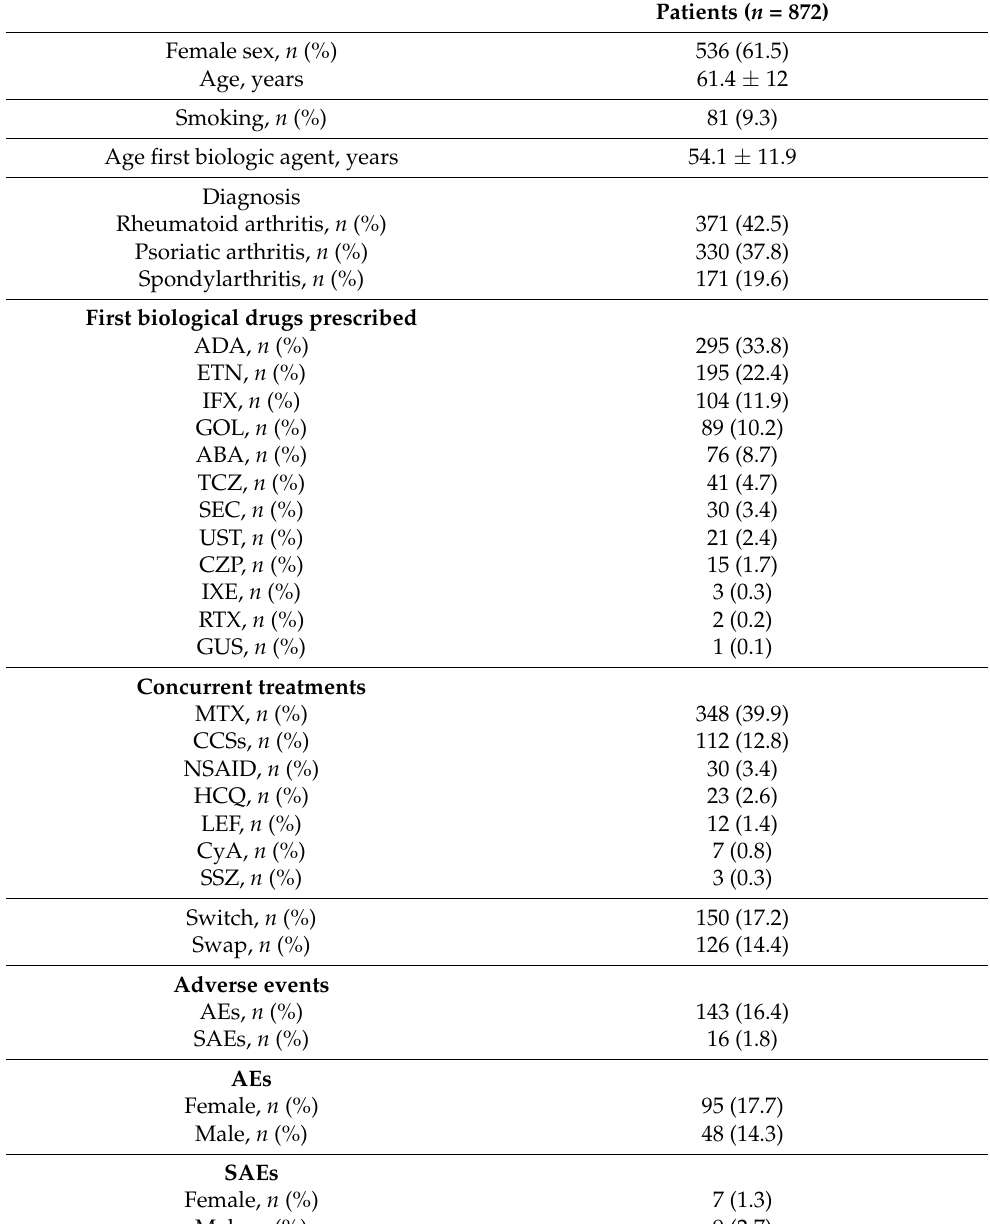
Table 1. Characteristics of the study